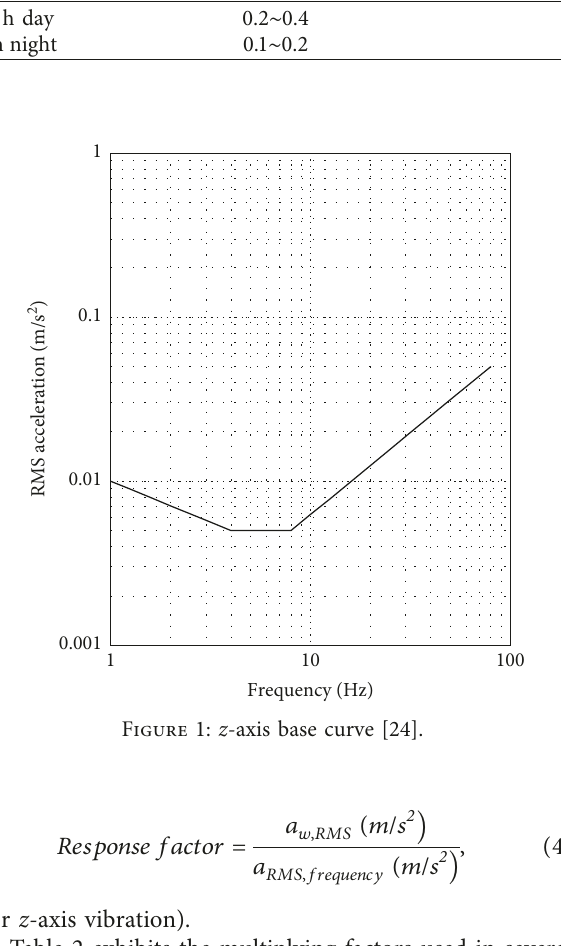
Table 1: VDV ranges which might result in various probabilities of adverse comment within residential buildings (BS 6472-1:2008) [23]. Time Low probability of adverse comment ( m / s 1 . 75 ) Adverse comment possible ( m / s 1 . 75 ) Adverse comment probable ( m / s 1 . 75 )